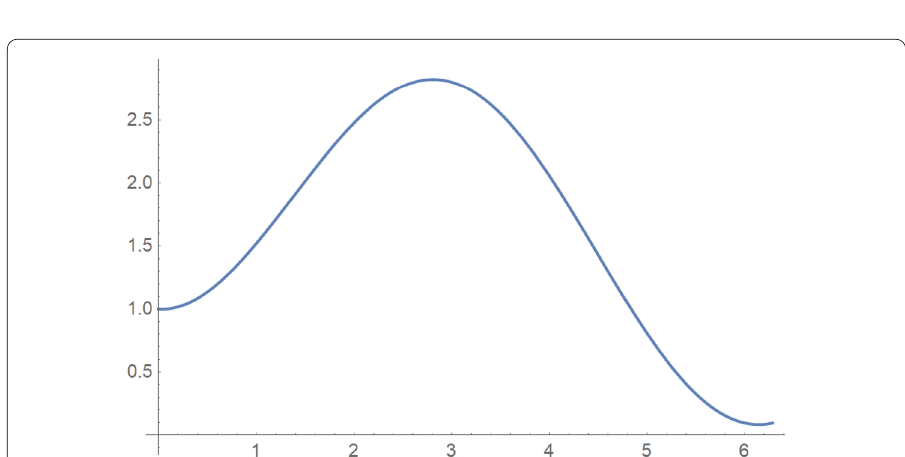
Figure 5 Solution of the problem for α =